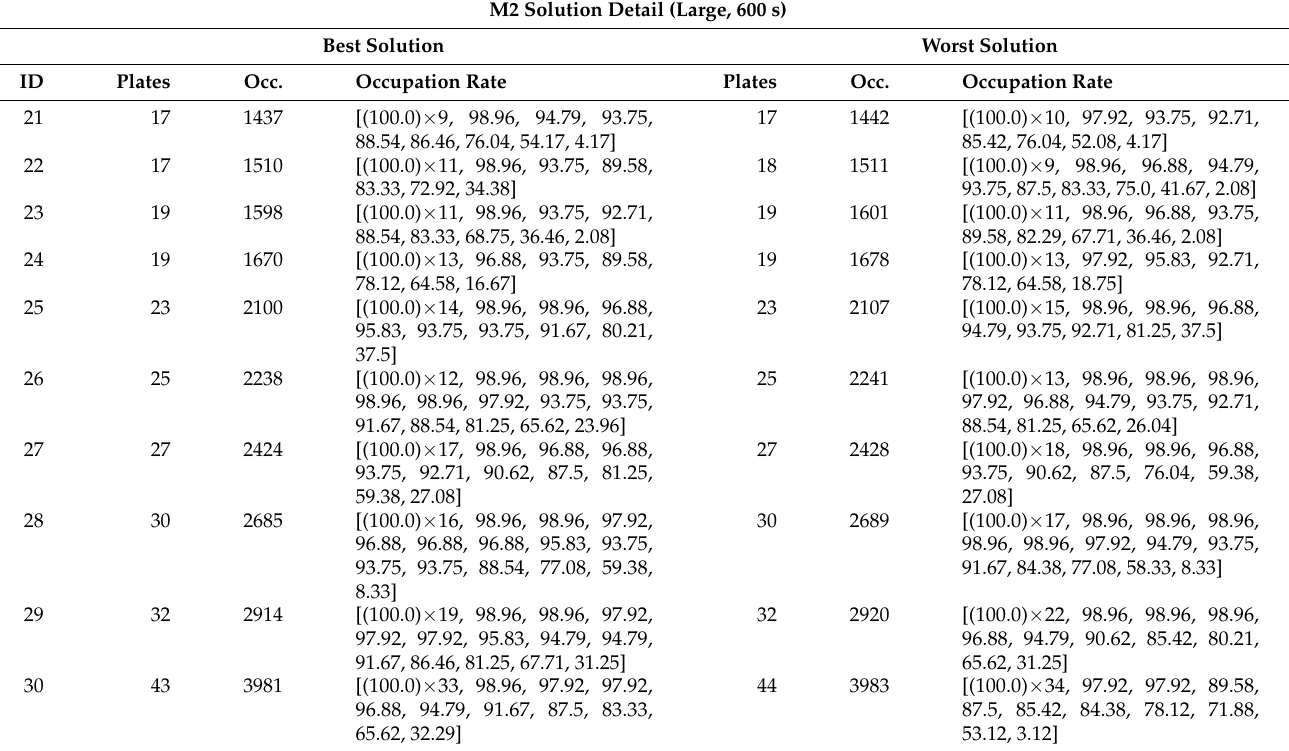
Table A16. M2 best and worst solutions obtained for large files, limited to